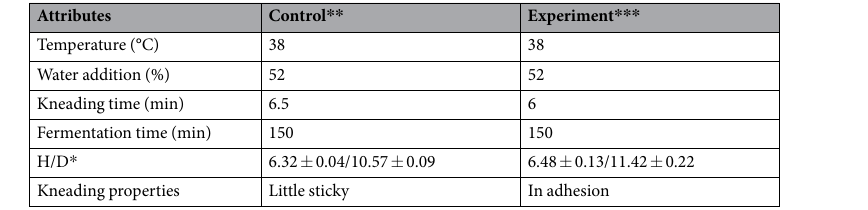
Table 2. The effects of XynHB supplementation on dough attributes. * Height-diameter. ** Whole bread without xylanase supplementation. *** Whole wheat bread supplemented with 1200 ppm